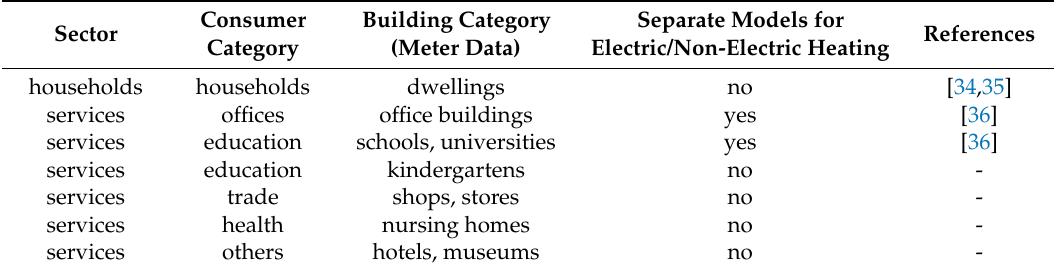
Table 1. Model overview, hourly electricity consumption.